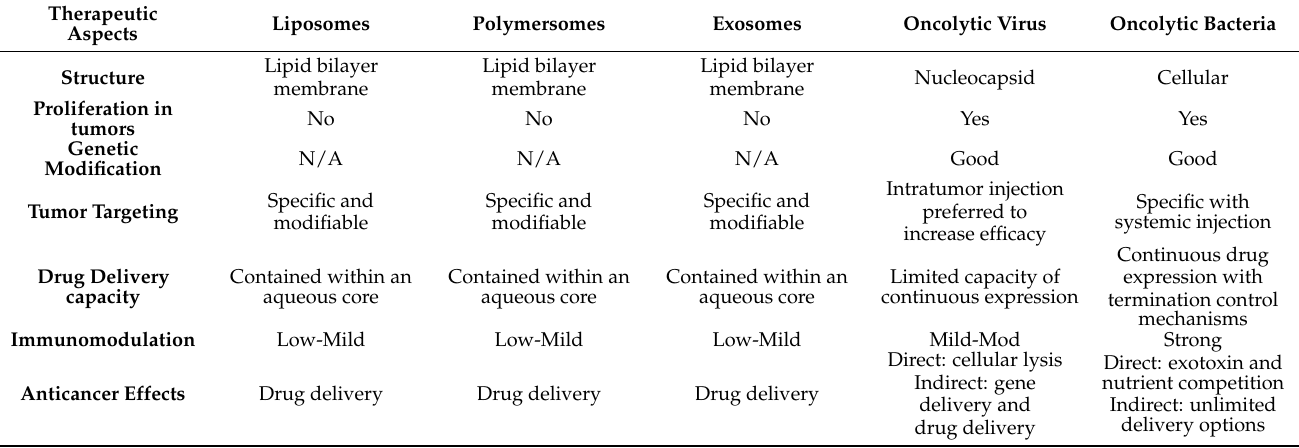
Table 1. A comparison of delivery systems for OB, OVs, liposomes, polymersomes and exosomes. This compares the difference in structure, proliferation in tumors, opportunity for genetic modification, tumor targeting, drug delivery capacity, immunomodulation, and anticancer effects and is a synthesis of the information contained in Sections 2–4 of this